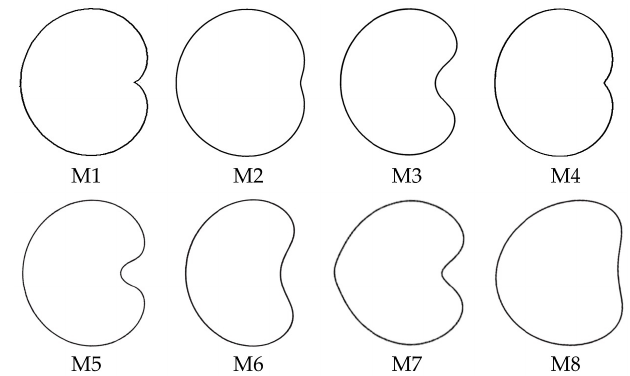
Figure 5. Left to right, top row: Model 1 (cardioid), Model 2 (flattened cardioid), Model 3 (open cardioid, Model 4 (flattened and elongated cardioid). Bottom row: Model 5 (open cardioid), similar to Model 3 but less open; Model 6 (open cardioid), similar to Model 3 but more open; Model 7, derived from the heart curve; Model 8 (slightly asymmetric figure).